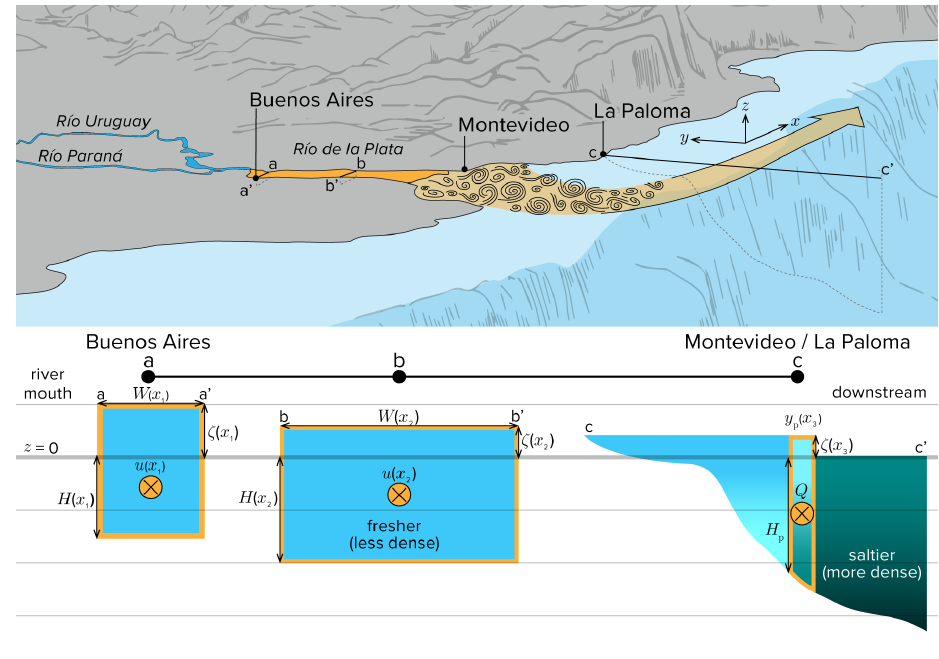
Figure 9. Schematic of the study region with key model quantities identified. The top shows a plan view of the region. The bottom shows cross sections at various locations in and around the Río de la Plata. Locations a and b are upstream near Buenos Aires, where the barotropic theory developed in Sect. 4.1 applies. Location c is downstream of Montevideo near La Paloma, where the baroclinic theory developed in Sect. 4.2 applies. At the bottom, yellow ⊗ identifies flow into the page, blue indicates fresher less dense water, and green denotes saltier more dense water. Other symbols and quantities are as defined in the text of Sect. 4.1 and 4.2. Illustration by Natalie Renier,